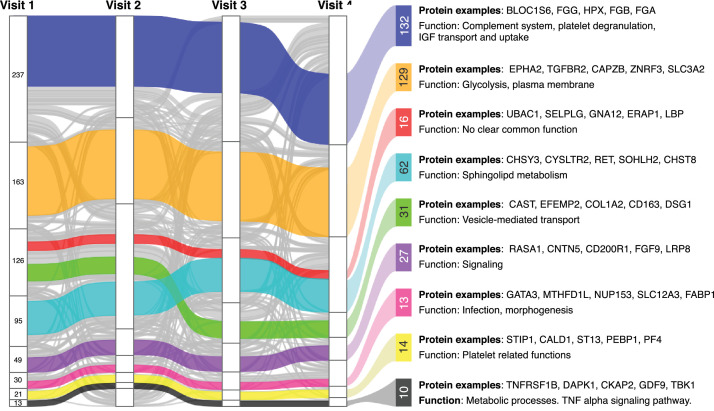
Networks of co-varying proteins. WGCNA was used to determine co-varying proteins per visit (stacked groups) and across visits (horizontal bands). Each vertical line represents one protein and its mega module membership in each visit. Proteins are coloured according to the core pattern they belong to. Proteins that do not belong to any core pattern are grey. Each core pattern is annotated to the right with the number of proteins it contains, a summary of associated pathways and GO terms, and examples of proteins following the given pattern. The examples of proteins given are the five proteins with the highest correlation to the core pattern eigengene.